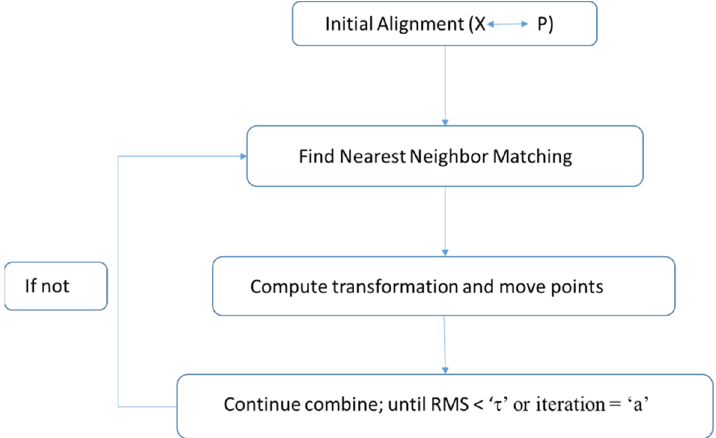
Figure 11. Iterative closest point (ICP) algorithm steps.